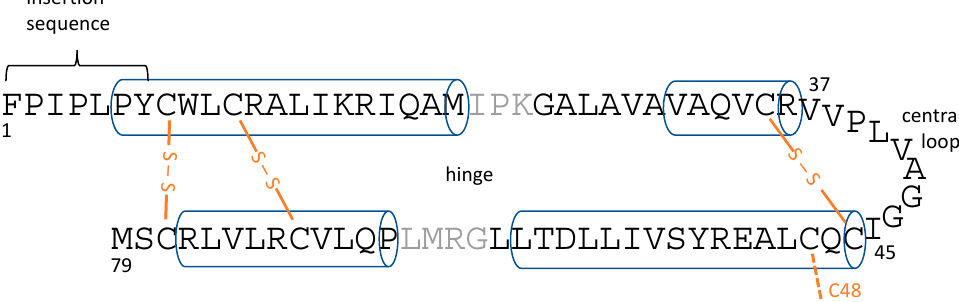
Figure 1. Overall topology of lung surfactant protein B (SP-B) helices and disulfide bonds with helical regions shown as cylinders and disulfide bonds in orange. C48 is thought to stabilize SP-B homo-dimers. Earlier simulation studies [40] pointed to the role of the central loop and hinge region flexibility in stabilizing bilayer defects. Note that the position of the helices varies slightly between simulations.